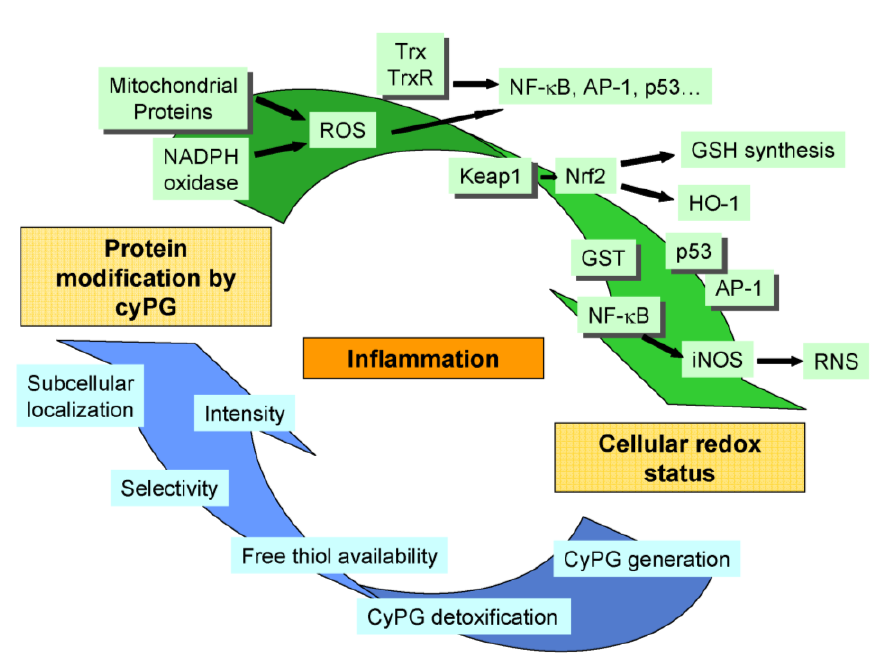
FIGURE 7. Reciprocal regulation between cellular redox status and protein modification by cyPG. Proteins shown in shaded boxes represent direct targets for cyPG addition. The function of various cyPG targets, including redox-sensitive transcription factors, such as NF-  B, AP-1, or p53, can be regulated by cyPG through multiple mechanisms (see